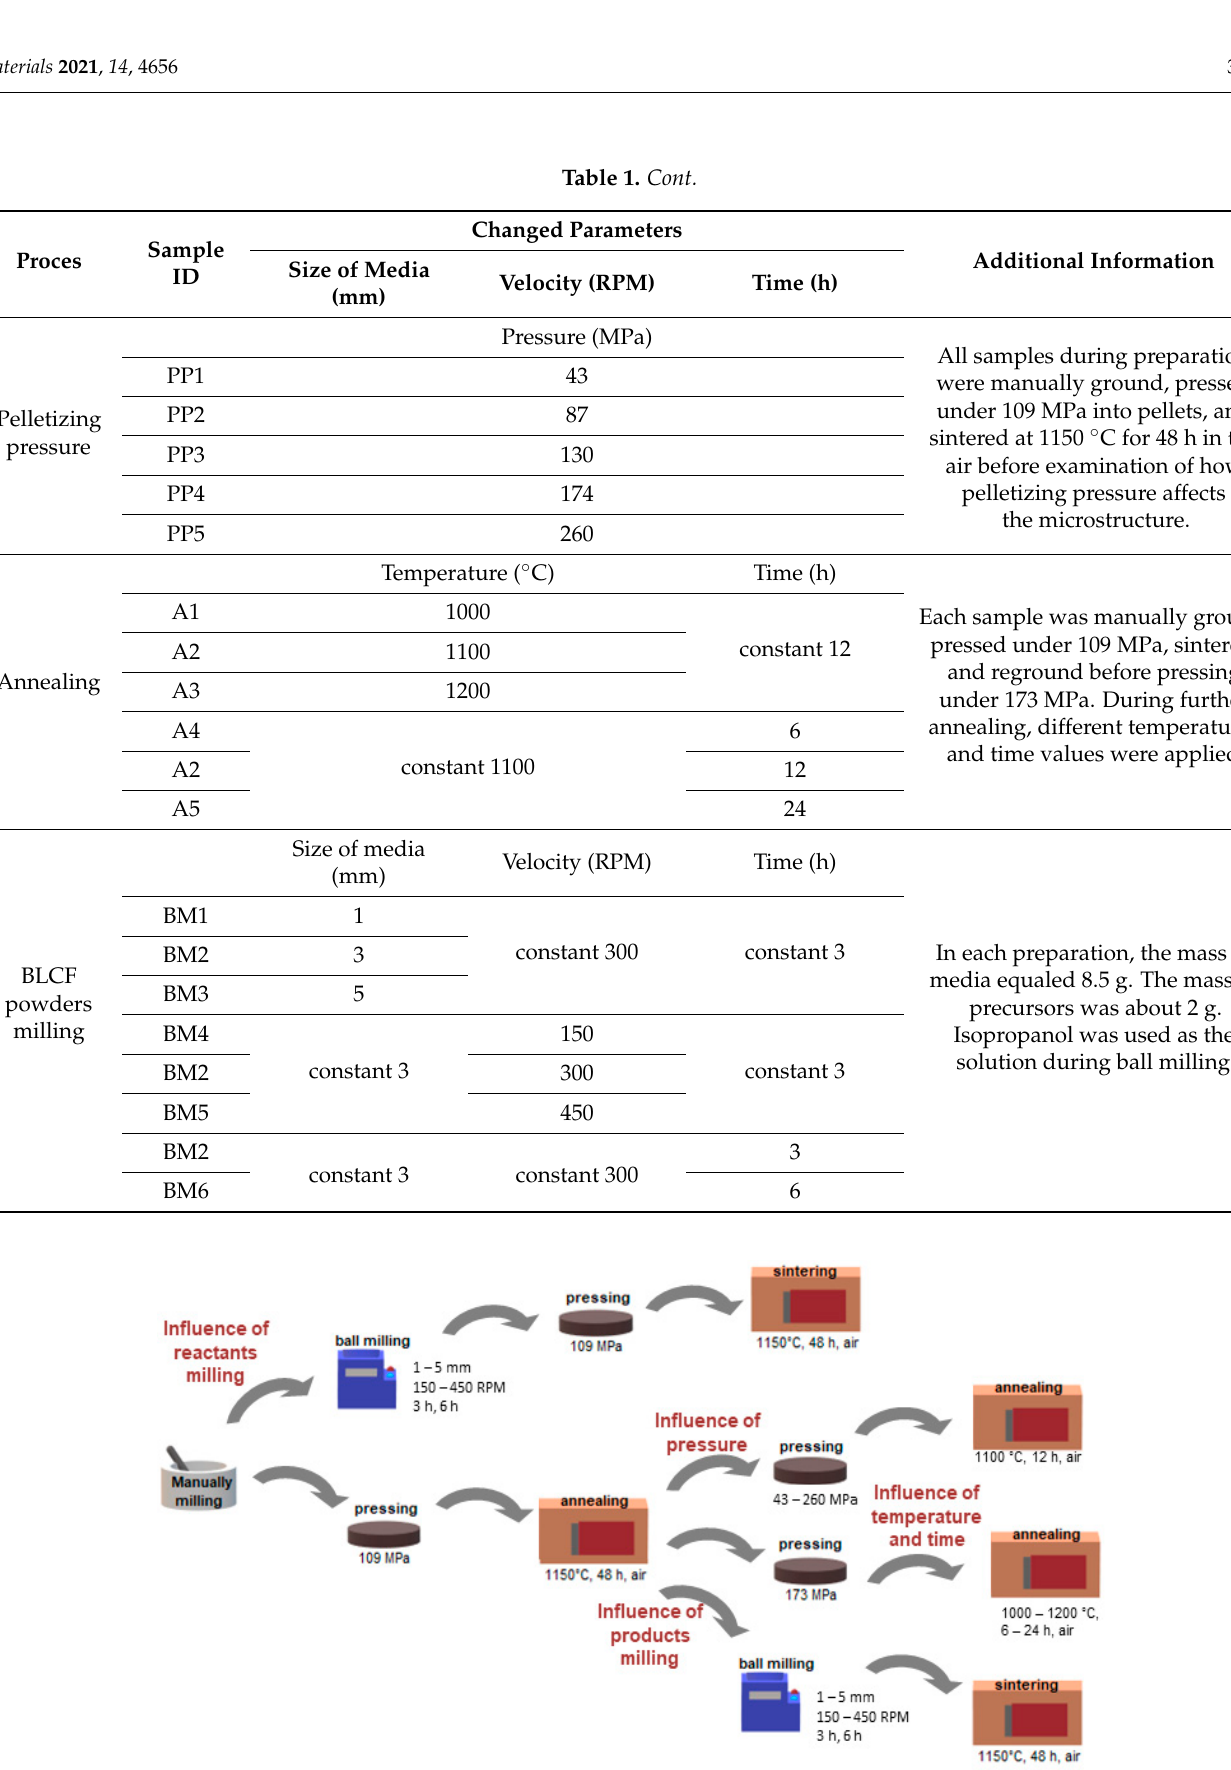
Figure 1. A diagram of the procedures used for the preparation of BLCF ceramics. They include grinding, ball milling, pressing, and annealing processes. Table 1. List of samples with particular synthesis parameters values used in this study.